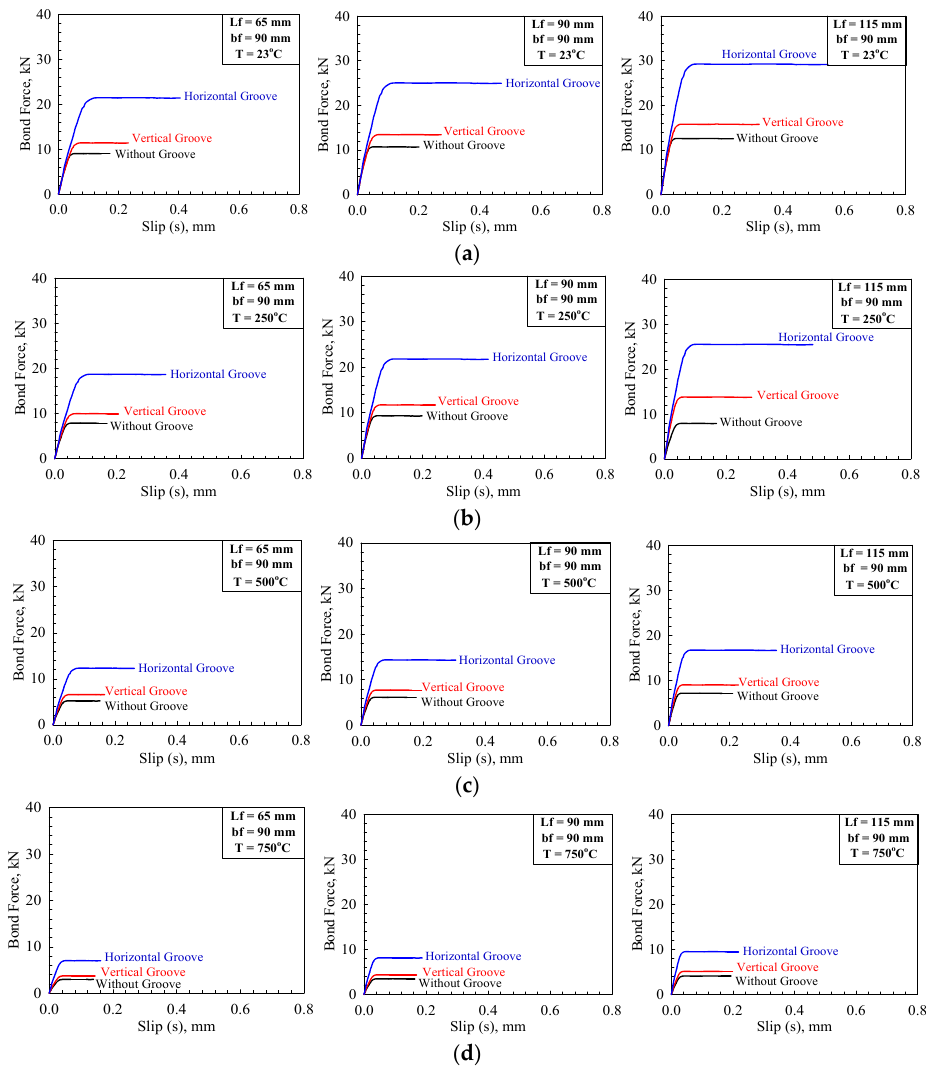
Figure 6. Typical bond-slip responses. ( a ) 23 °C; ( b ) 250 °C; ( c ) 500 °C; ( d ) 750 °C.